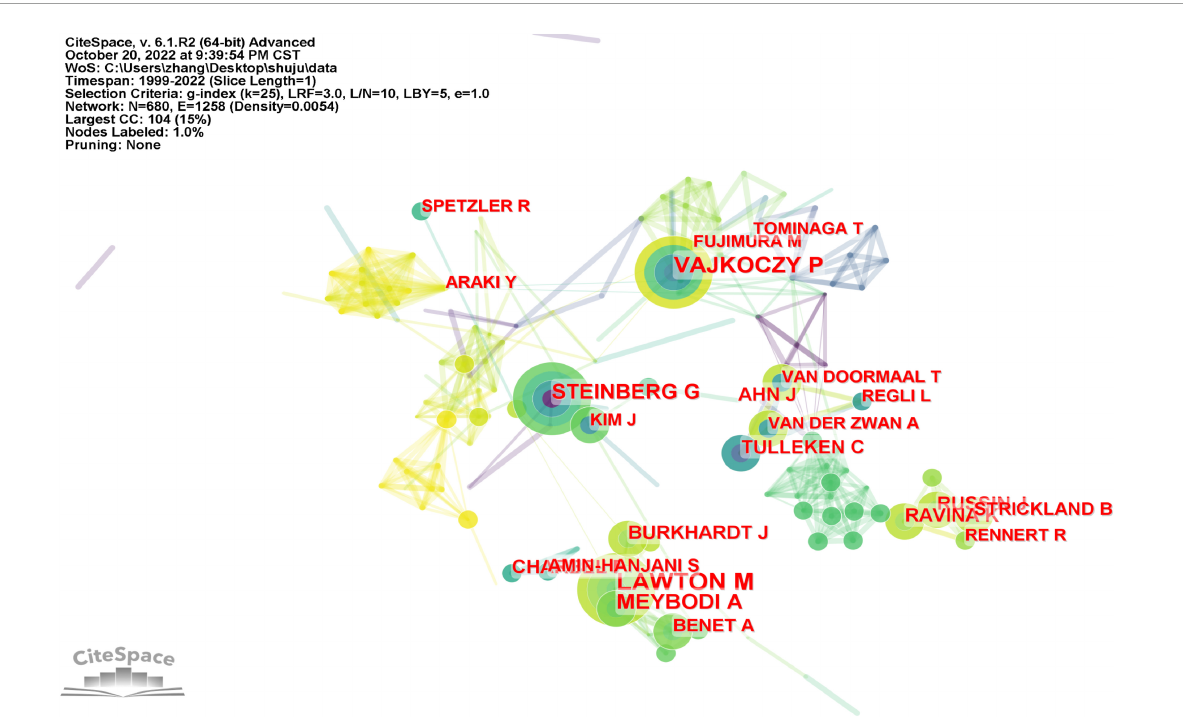
FIGURE4 Analysis of authors published the most articles based on the CiteSpace visual map. Each node represents an author’s name, and each line represents the central collaboration between authors. The thicker the line, the closer the collaboration between the authors.